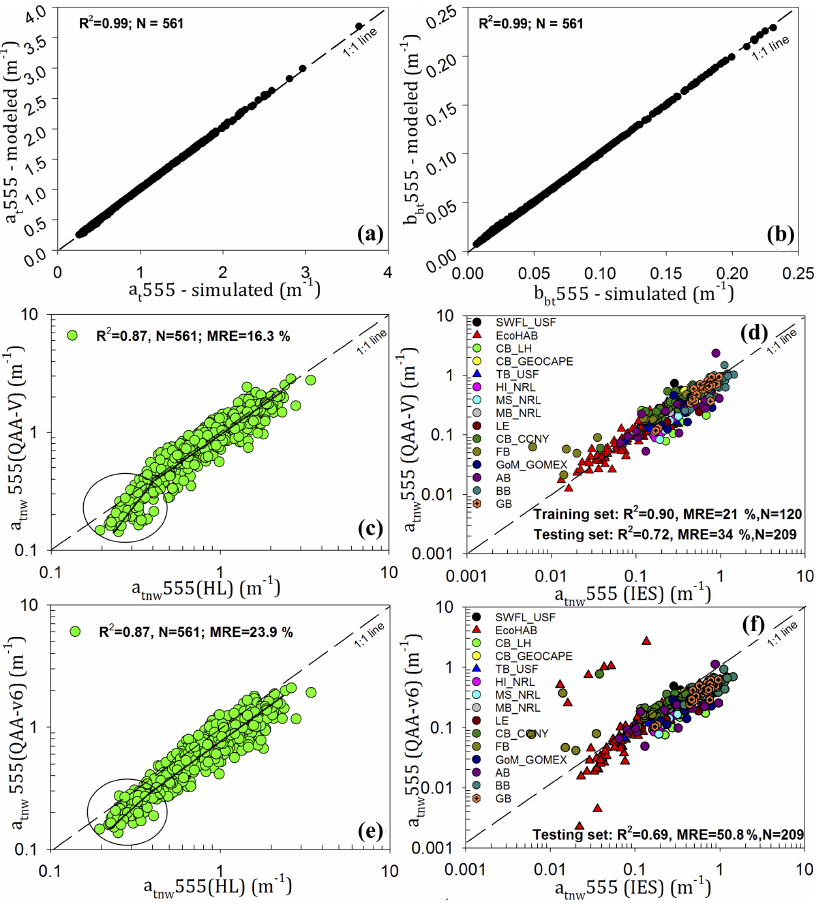
Figure 4. Validation of R 0 − rs vs. u model using HL data for (a) a t 555 and (b) b bt 555. Validation of QAA-V-modeled a tnw 555 with “true” a tnw 555 for (c) the HL synthetic dataset (bias log10 = − 0 . 0208, RMSE log10 = 0 . 0963m − 1 ) and (d) IES dataset (bias log10 = − 0 . 0294, RMSE log10 = 0 . 190m − 1 ). Validation of QAA-v6-modeled a tnw 555 with “true” a tnw 555 for (e) the HL synthetic dataset (bias log10 = − 0 . 1180, RMSE = 0 . 1490m − 1 ) and (f) IES dataset (bias = − 0 . 1252, RMSE = 0 . 278m − 1 ). Note: the training set includes log10 log10 log10 EcoHAB and Tampa Bay data (Table 1). IOP measurements of Galveston Bay (this study) are shown with orange hexagons. MRE: absolute mean relative error (%). TB: Tampa Bay, AB: Apalachicola Bay, BB: Barataria Bay, CB: Chesapeake Bay, FB: Florida Bay, GoM: Gulf of Mexico, HI: Horn Island, LE: Lake Erie, MS: Mississippi Sound, MB: Mobile Bay, SWFL: southwest Florida, GB: Galveston Bay (Table